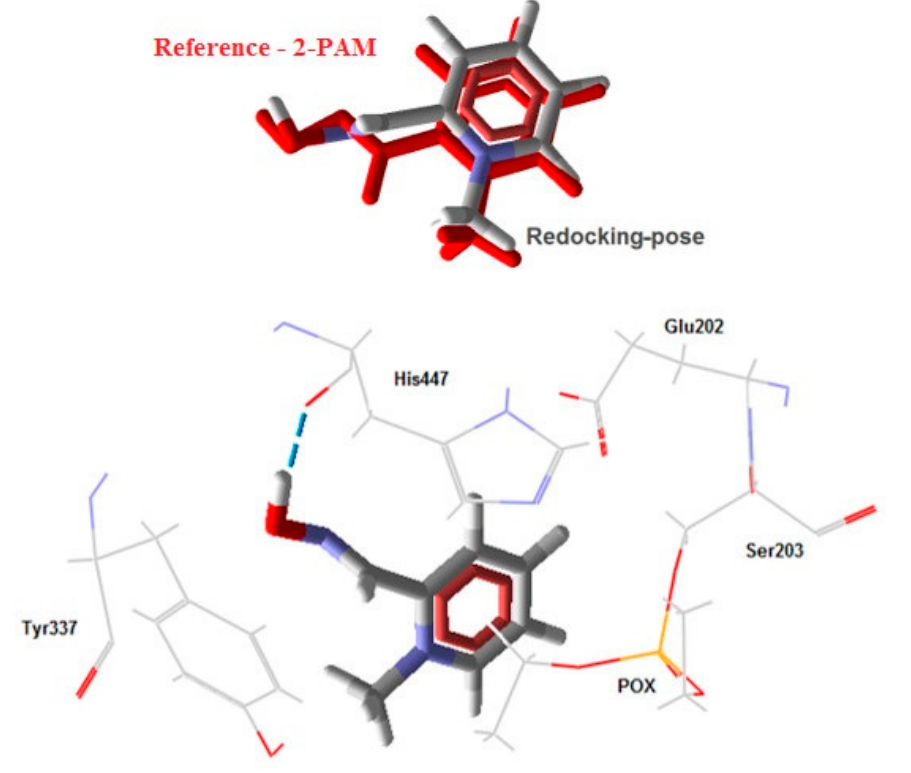
Figure 5. Best redocking pose.